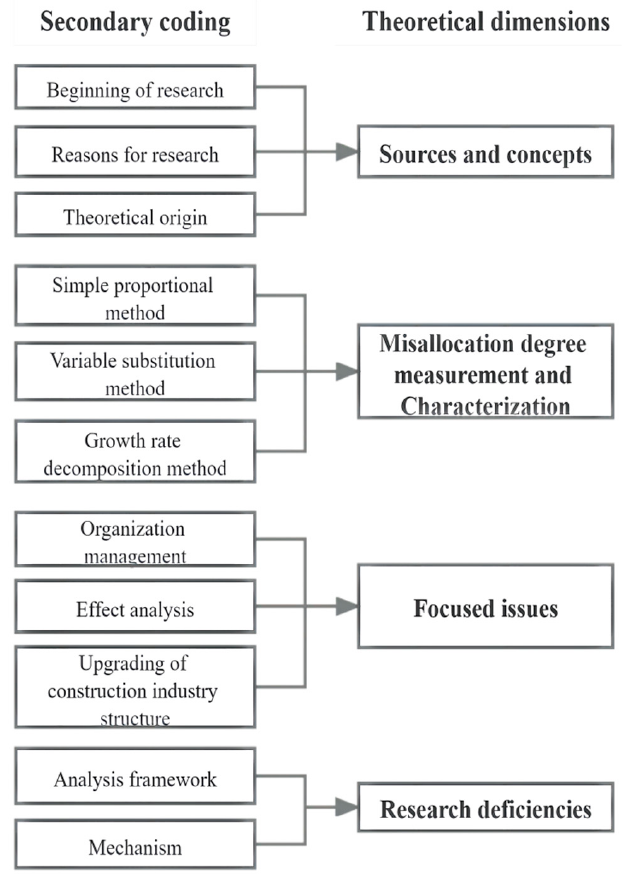
Figure 5. Selective coding data structure.